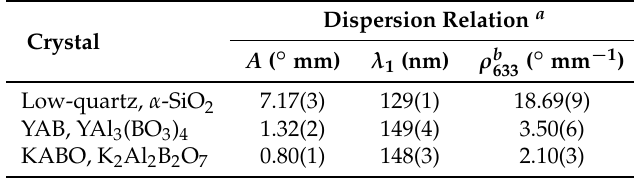
Table 1. Dispersion relations for the optical rotatory power of low-quartz, YAB, and KABO.